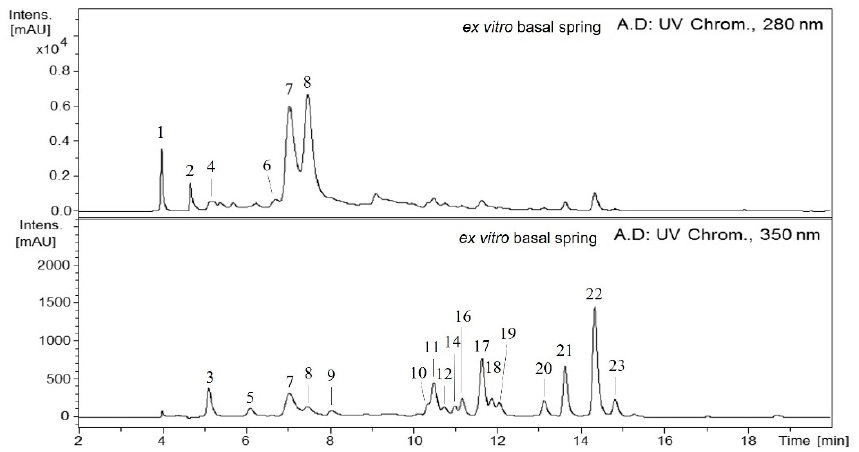
Figure 2. HPLC ‐ DAD ‐ ESI (Ion Trap) ‐ MS n (280, 350 nm) phenolic profile of methanolic extract from ex vitro basal spring leaves of A. chilensis . Identity of compounds is shown in Tables 1 and 2.